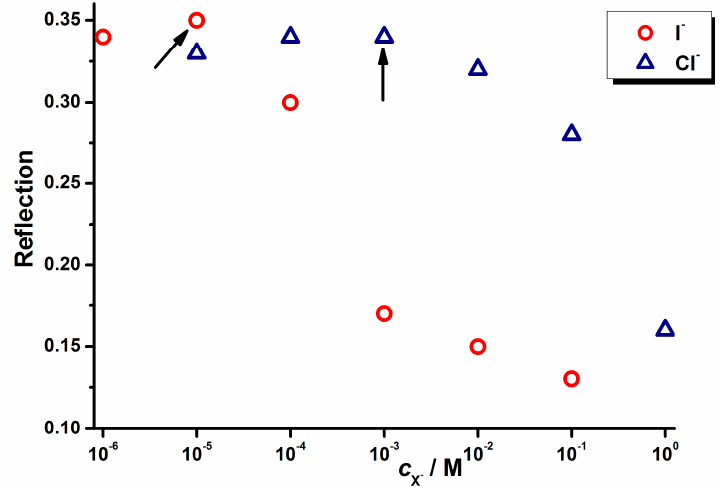
Figure 9. The reflection for green channel as a function of iodide and chloride concentration. The limit of detection was estimated as 10 − 5 – 10 − 4 M for iodide and 10 − 3 – 10 − 2 M for chloride using of detection was estimated as 10 − 5 –10 − 4 M for iodide and 10 − 3 –10 − 2 M for chloride using Tl:PAR Tl:PAR 1:1 complex ( C Tl = 0.5 mM). 1:1 complex ( C Tl = 0.5